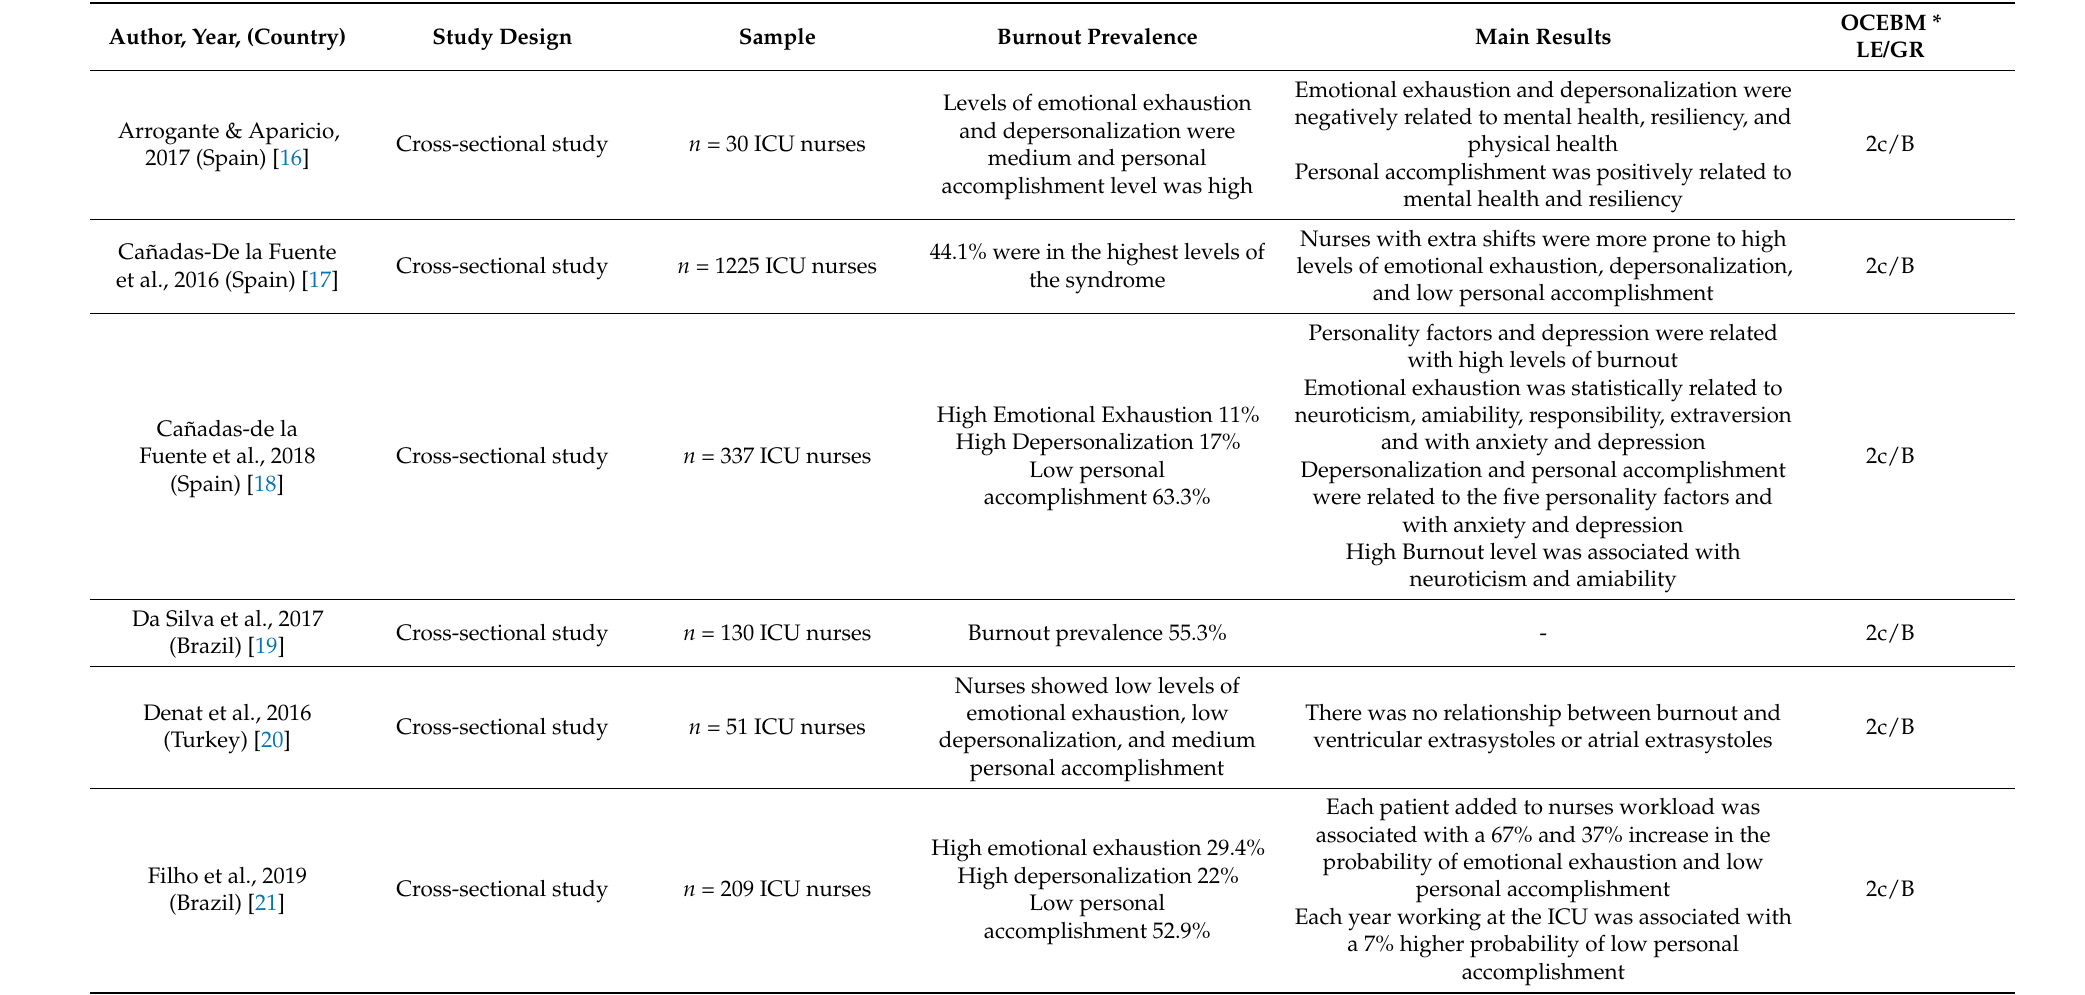
Table 1. Characteristics of the included studies ( n =